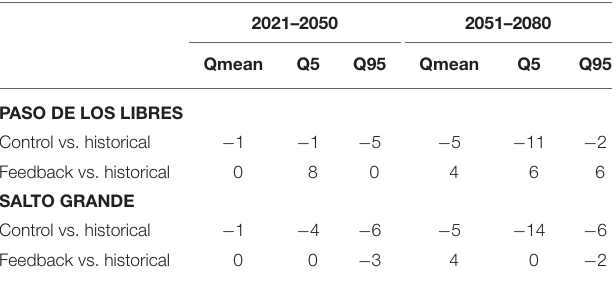
TABLE 3 | As in Table 2 but for the closing points in the Uruguay River: Paso de los Libres and Salto